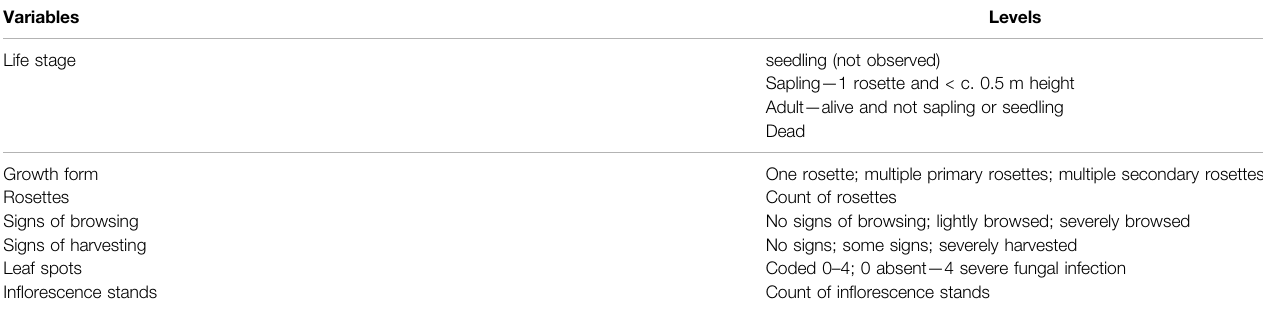
TABLE 1 | Variables recorded in fi eld describing the demography and vitality of Tombat trees.